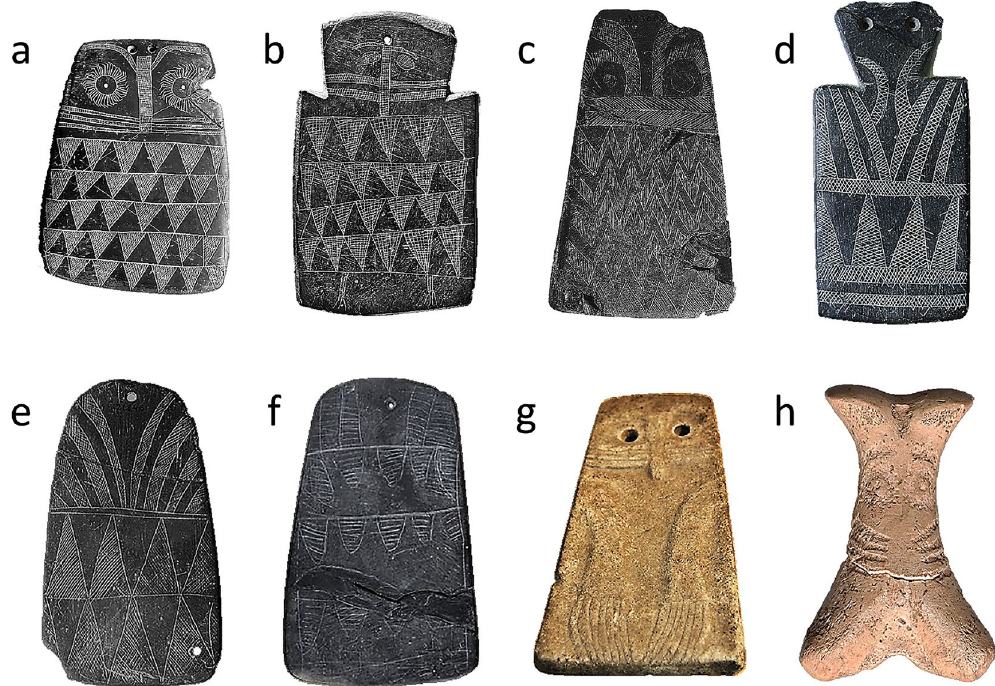
Slate plaque from Cerro de las Cabezas, Valencina de la Concepción, Sevilla, Spain (Museo Arqueológico de Sevilla, REP25837). ( b ) Slate plaque from anta do Curral da Antinha, Arraiolos, Evora, Portugal (Museu Nacional de Arqueologia de Portugal [MNA], Lisboa, 2003.37.1). ( c ) Slate plaque from anta 1 da Farisoa, São Marcos do Campo, Reguengos de Monsaraz, Evora, Portugal (MNA, Lisboa, 32300). ( d ) Slate plaque with carved head from anta da Marquesa, Marvão, Portalegre, Portugal (MNA, Lisboa, 8195). ( e ) Slate plaque from anta Grande do Olival da Pega, Reguengos de Monsaraz, Evora, Portugal (MNA, Lisboa, 985.45.21). ( f ) Slate plaque from anta Grande do Olival da Pega, Reguengos de Monsaraz, Evora, Portugal (MNA, Lisboa, 985.45.15). ( g ) Sandstone plaque from anta da Horta, Alter do Chão, Portoalegre, Alentejo, Portugal (Museu da